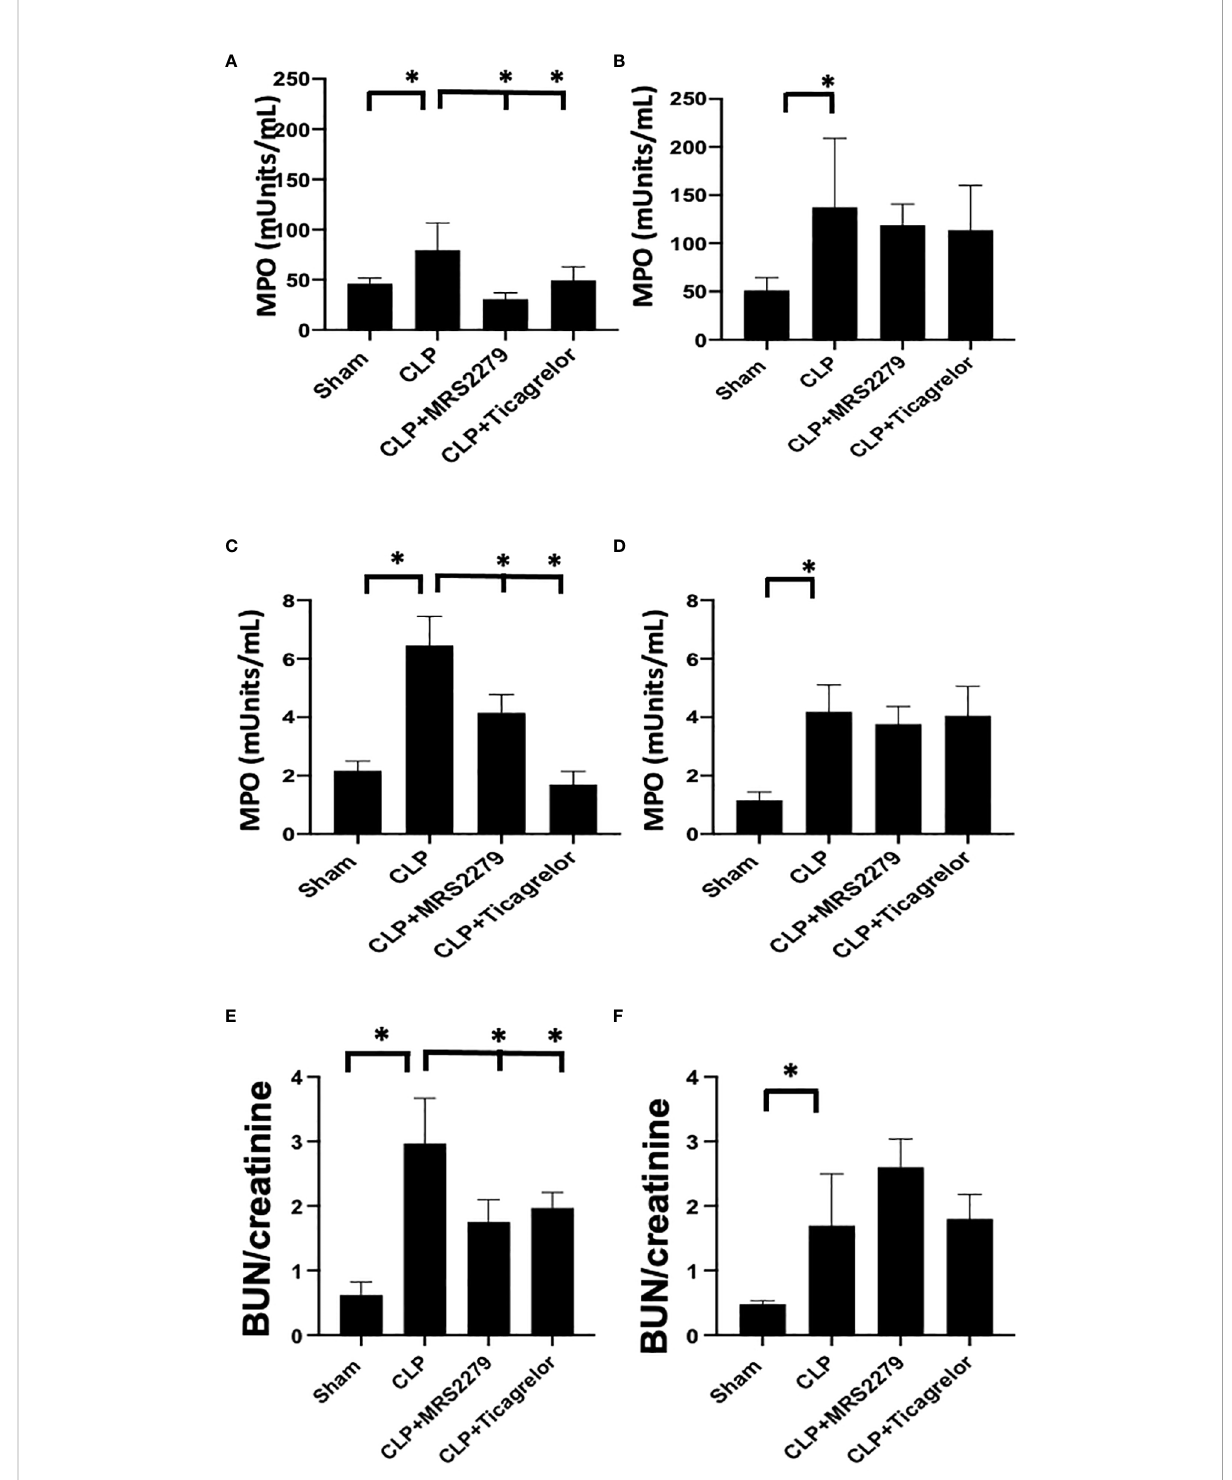
FIGURE 4 P2Y 12 or P2Y 1 antagonism attenuates lung and renal MPO activity in sepsis in a sex-related manner. (A – D) MPO analysis was performed in the lung (A, B) and kidney (C, D) samples of Sham, CLP, MRS2279-treated CLP, and ticagrelor-treated CLP in male (A, C) and female mice (B, D) . Values are expressed as mUnits/mL, mean ± SEM. (n = 5). (*P < 0.05). (E, F) Blood urea nitrogen (BUN)/Creatinine ratios were determined 24 hours post- surgery in plasma samples of Sham, CLP + CLP, MRS2279-treated CLP, and ticagrelor-treated CLP in male (E) and female mice (F)